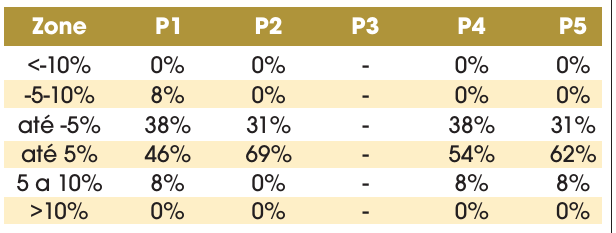
Table 2 – Summary of percentage of occurrence of the compressive strength of each point relative to point